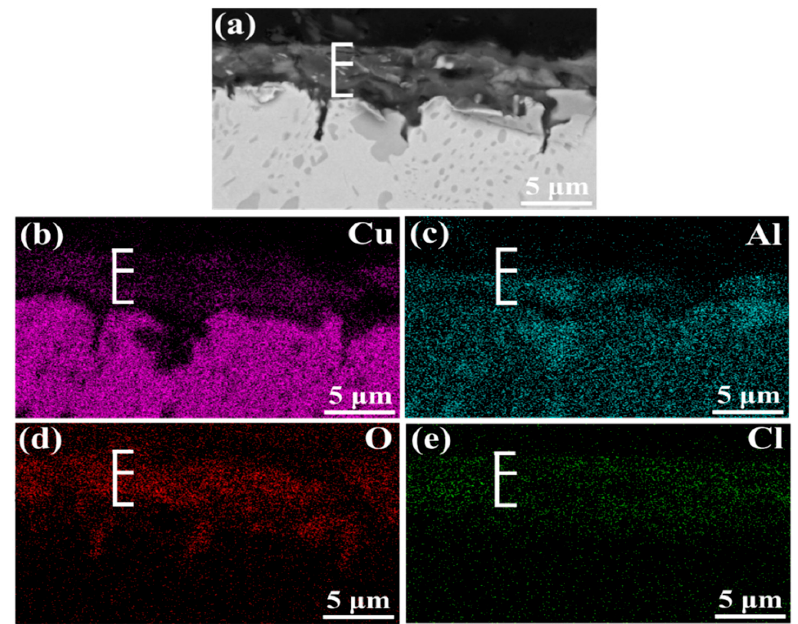
Figure 4. EDS elemental maps of corrosion product film on NAB alloy in cross-section: ( a ) morphology; ( b ) Cu map; ( c ) Al map; ( d ) O map; ( e ) Cl map.